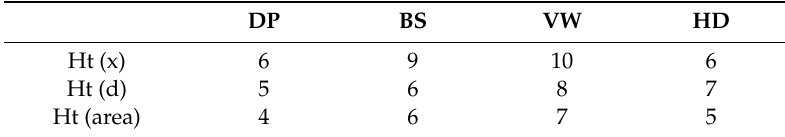
Table 2. Ht-index of three parameters for each algorithm on the source data of the British coastline. (Note: 40% as threshold for the head / tail breaks